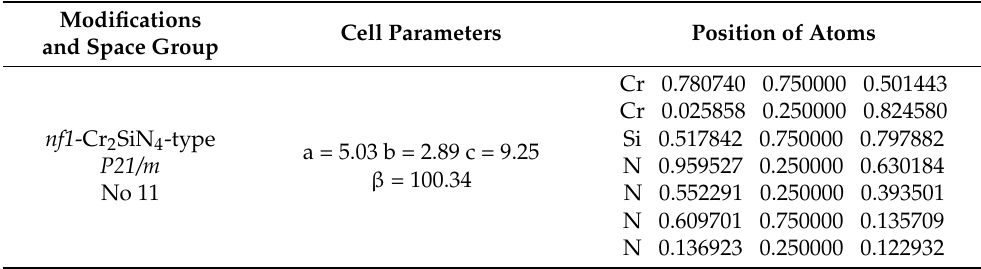
Figure 4. Visualization of non-favorable Cr 2 SiN 4 modifications: ( a ) nf1 -Cr 2 SiN 4 -type in space group P21/m (no. 11); ( b ) nf2 -Cr 2 SiN 4 -type in space group Cc (no. 9). Green, red, and yellow spheres denote Cr, Si, and N atoms, respectively. Table 3. The modifications, space groups, unit cell parameters, and atomic positions for non-favorable Cr 2 SiN 4 modifications found using global optimization and later optimized at the GGA-PBE level of